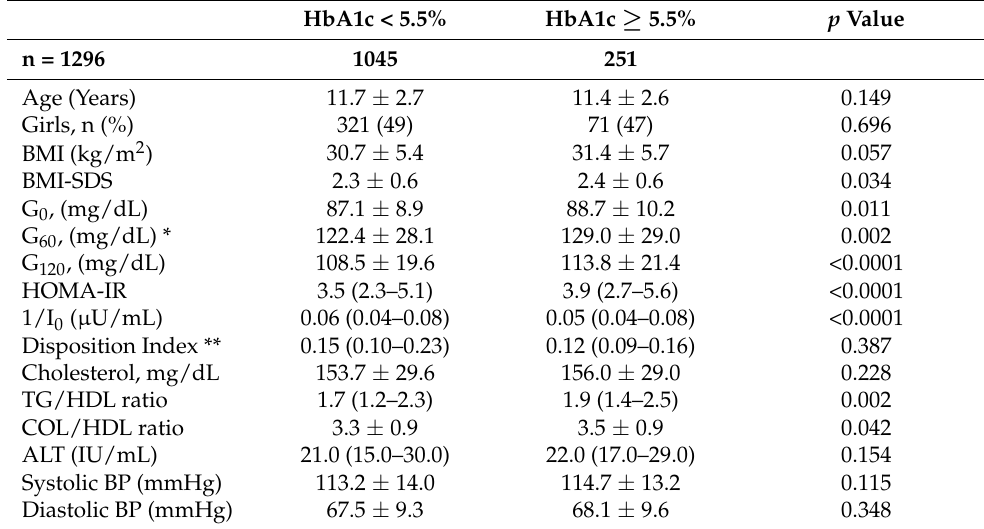
Table 2. Characteristics of youths with HbA1c < 5.7% reclassified by cut-off of 5.5%.